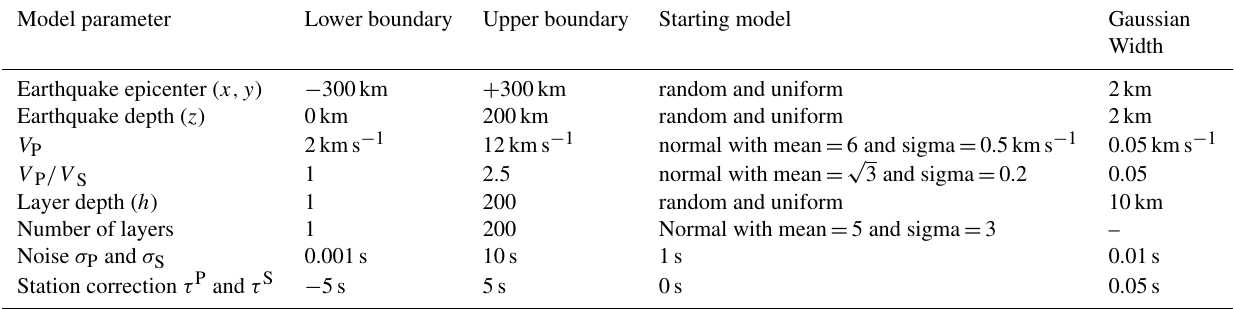
Table 2. Prior distribution (model space), starting model, and width of Gaussian distribution for each model parameter. Model parameter Lower boundary Upper boundary Starting model Gaussian Width Earthquake epicenter ( x,y ) − 300km + 300km random and uniform 2km Earthquake depth ( z ) 0km 200km random and uniform 2km V P 2kms − 1 12kms − 1 normal with mean = 6 and sigma = 0.5kms − 1 0.05kms − 1 =√ V P /V S 1 2.5 normal with mean 3 and sigma = 0.2 0.05 Layer depth ( h ) 1 200 random and uniform 10km Number of layers 1 200 Normal with mean = 5 and sigma = 3 – Noise σ P and σ S 0.001s 10s 1s 0.01s Station correction τ P and τ S − 5s 5s 0s